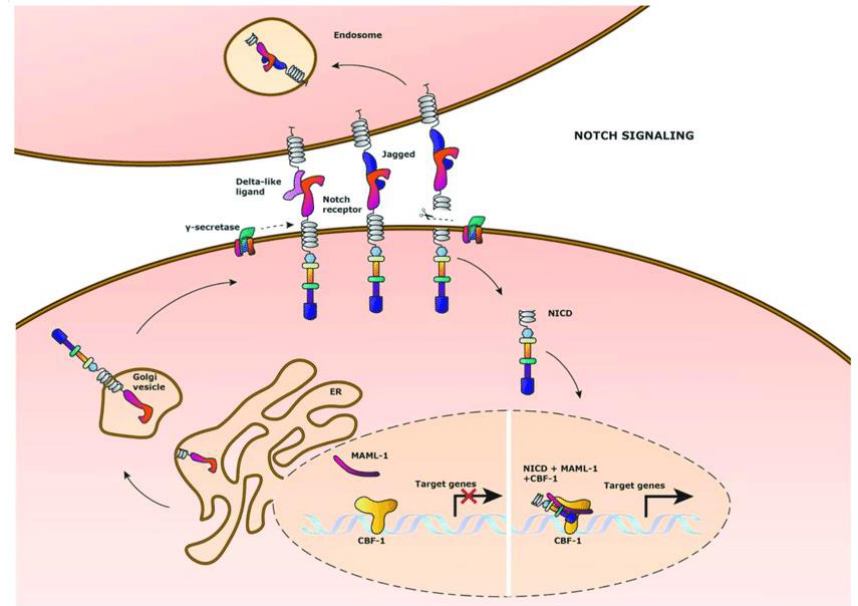
Figure 1. Notch signalling pathway. Figure replicated from [53] under Creative Commons license, provided at https://creativecommons.org/licenses/by/4.0/ (accessed on 29 January 2023). Changes have been made to the figure legend.